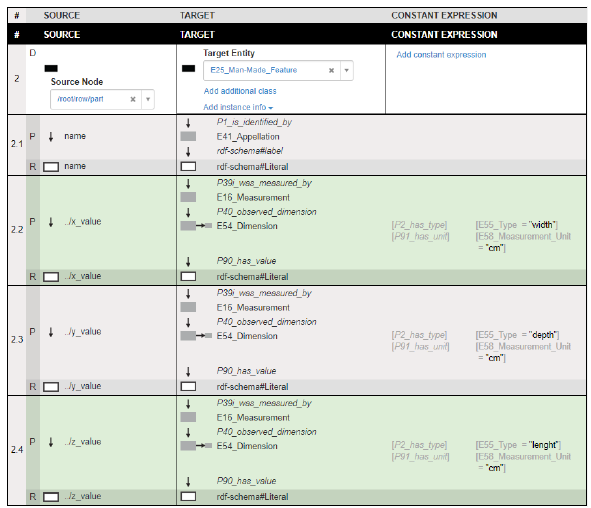
Figure 6. Mapping of data about Nefertari Temple in Abu Simbel and dimensions of its parts ( E25 Man-Made Feature ) – 3M